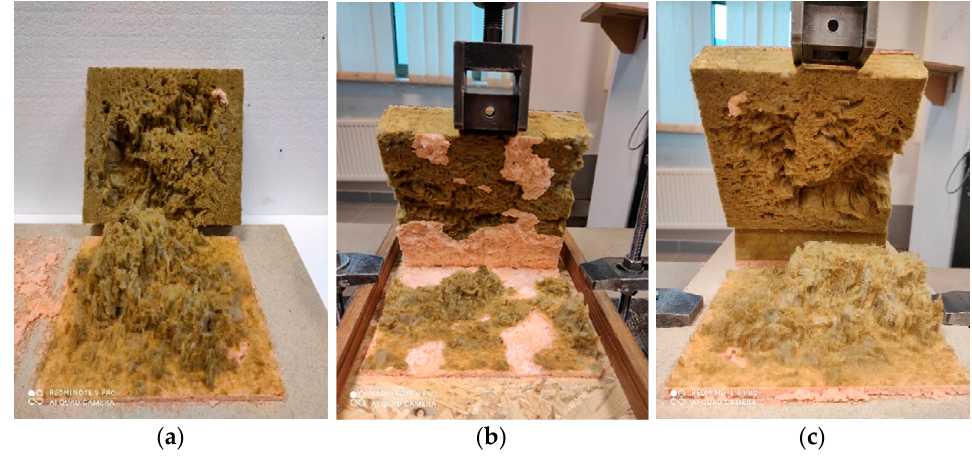
Figure 8. Model of damage—average values for the series: ( a ) 23/50/8, ( b ) 25/30/8, ( c ) 25/90/8 and ( d ) 5/-/8 (C/MW—cohesive damage within the MW, C/PU—cohesive damage within the PU adhe- sive).